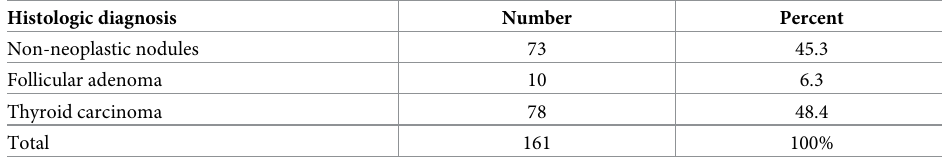
Table 3. Histopathologic diagnosis of 161 thyroid nodules.